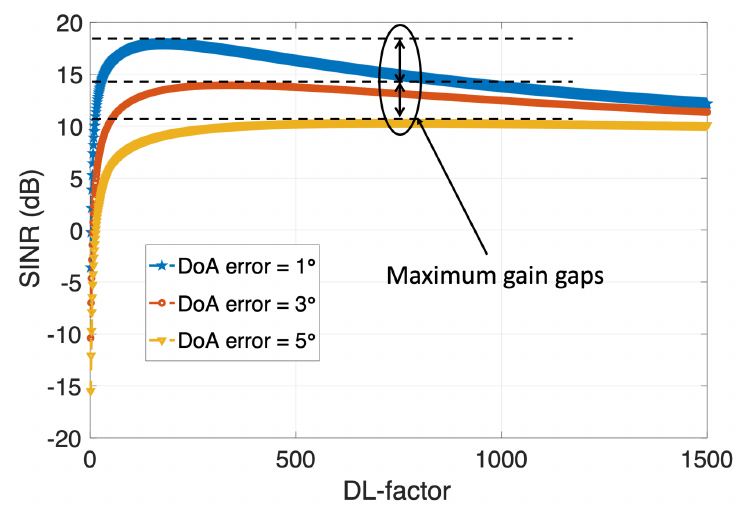
Figure 3. SINR output of DL beamforming versus the DL-factor for different DoA errors. The maximum achievable gain decreases as DoA errors increases, creating gaps between the curves of different DoA